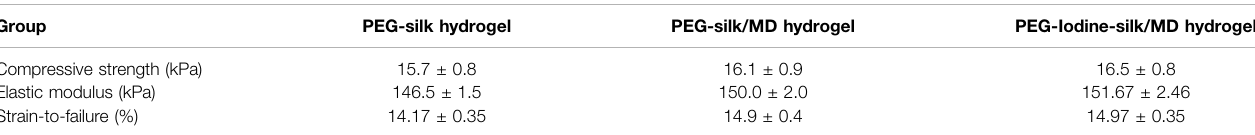
( Figure 3C ), further con fi rming the FTIR results. The results indicated that PVP-I and MD had a negligible in fl uence on the